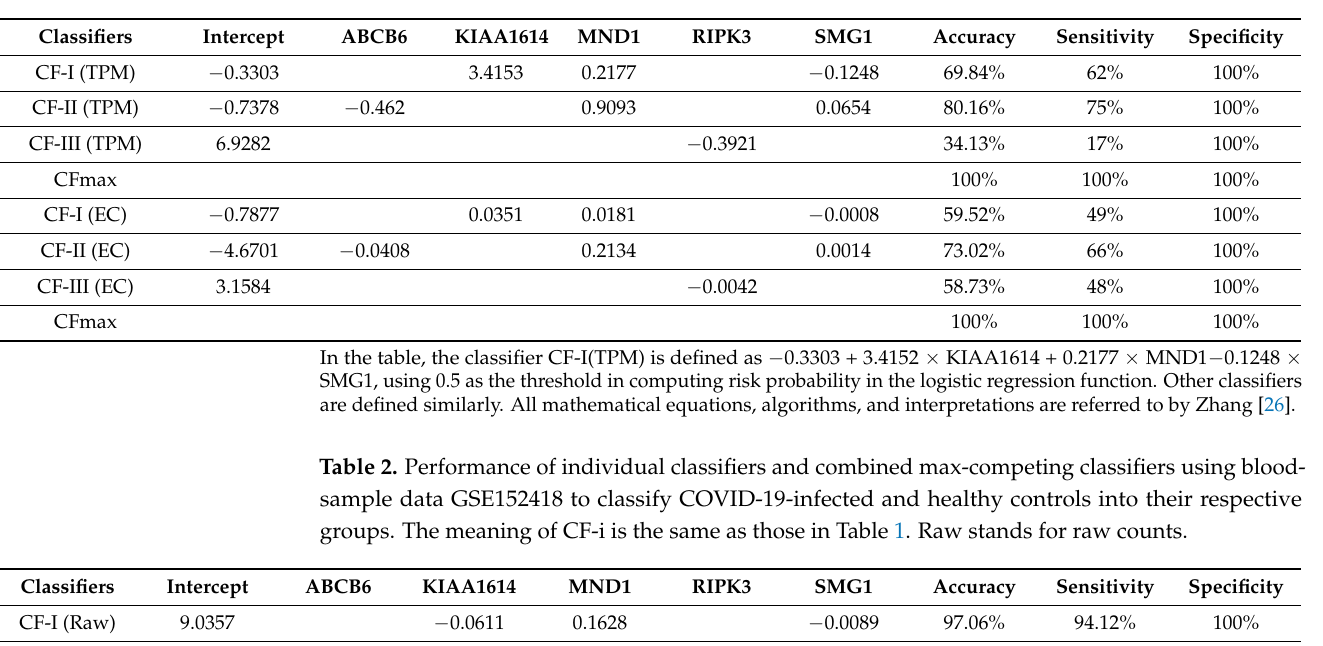
Table 1. Performance of individual classifiers and combined max-competing classifiers using blood- sample data GSE157103 to classify hospitalized COVID-19 patients and other types of patients (as control) into their respective groups. CF-I, II, and III are three different classifiers. CFmax = max (CF-I, II, III) is the combined max-competing classifier. TPM stands for transcripts per million, and EC stands for expected counts. The numbers are fitted coefficient values.